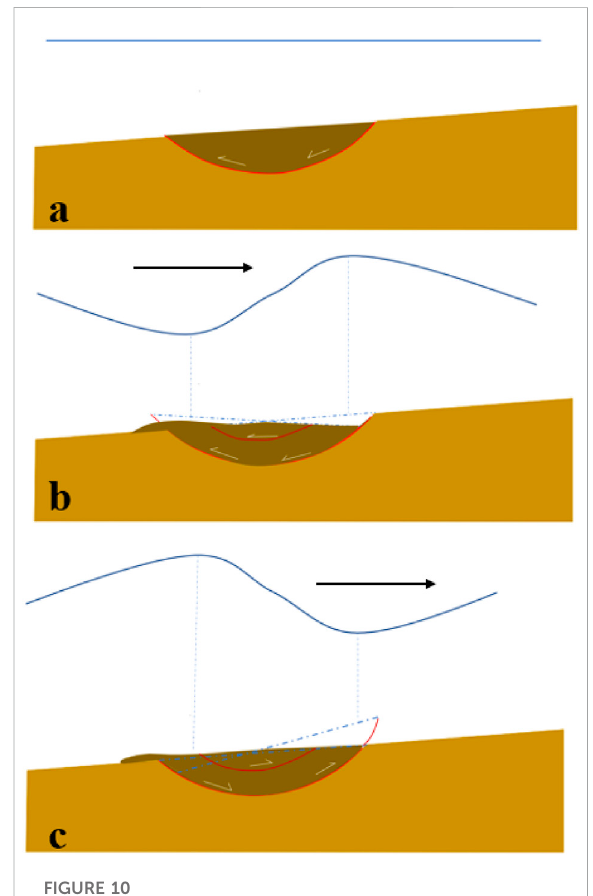
FIGURE 10 Schematic diagram of seabed deformation and sliding in the study area. (A) Shows that the seabed slides along the slope of the sliding surface under the action of gravity, (B) shows that the direction of shear stress formed by wave crest and wave trough is opposite to the wave direction, and the soil will oscillate clockwise, and (C) shows that the direction of shear stress formed bywavecrestandwavetroughisthesameasthatofthewave,and the soil will oscillate